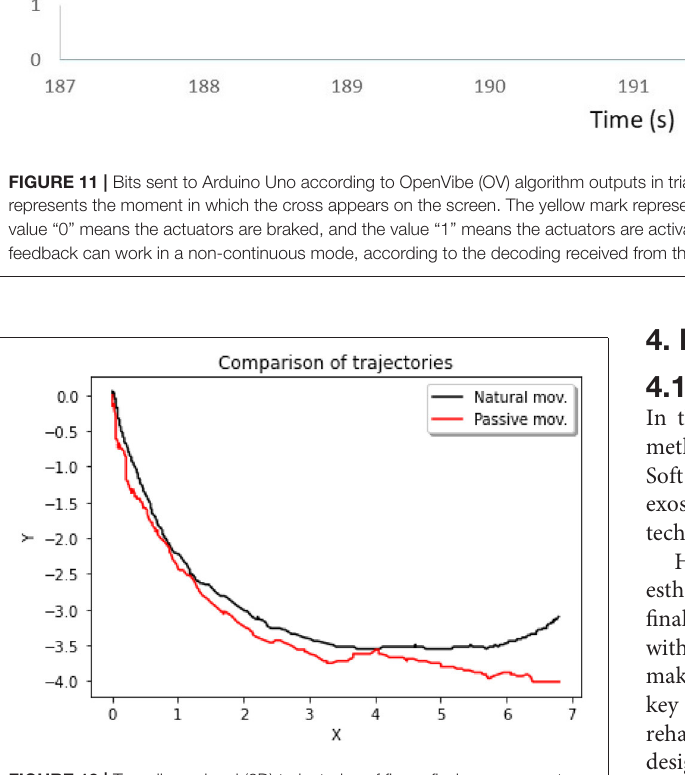
FIGURE 12 | Two-dimensional (2D) trajectories of finger flexion movements. The black curve represents the trajectory of the index fingertip during the execution of an active/natural movement. The red curve represents the passive